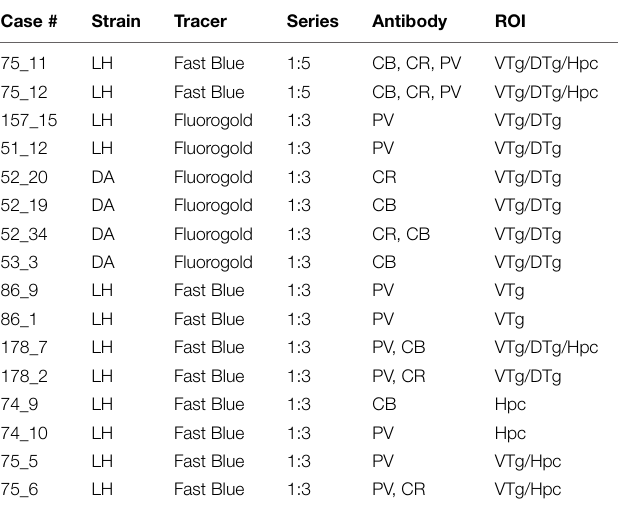
TABLE 1 | List of individual cases showing the strain of rat (LH, Lister Hooded; DA, Dark Agouti), the retrograde tracer injected into the mammillary bodies, the proportion of sections analyzed, the antibodies employed (CB, calbindin; CR, calretinin; PV, parvalbumin), and the regions of interest (ROI) that were scrutinized (DTg, dorsal tegmental nucleus of Gudden; Hpc, dorsal and ventral hippocampal formation; VTg, ventral tegmental nucleus of